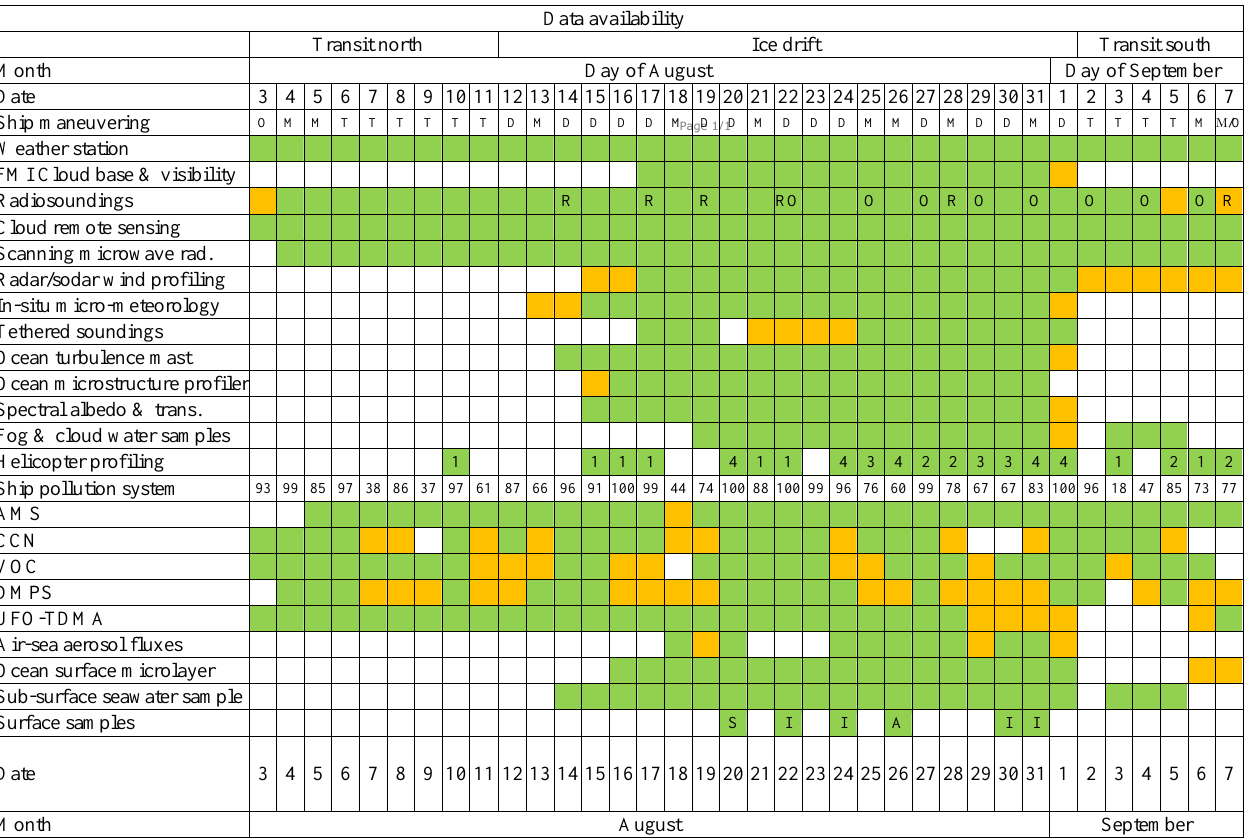
Table 4. Overview of availability of data from different instruments or groups of instruments from ASCOS at different times (3 August corresponds to DoY 215 and 7 September corresponds to DoY 251). Green fields indicate essentially complete data coverage, within the limitations of the deployment, and yellow fields indicate (somewhat arbitrarily) that some limitation in availability was present, either due to problems with the instrumentation, ship pollution, incomplete installations or reduced sampling for some other reason. White fields indicate that data are essentially missing; note that some very small fraction of data may still be present. For some data additional information is provided. “Ships maneuvering” indicates ship’s operation (O: open water sampling, M: MIZ sampling, T: transit, D: drifting with ice, M: temporarily moving the ship while drifting). A fraction of the soundings were augmented by special sensors indicated by “R” for radioactivity and “O” for ozone. For the ship’s pollution system, the numbers indicate the fractional time without any pollution detected, in %. A green field in the helicopter profile column indicates that at least one profile was made on that day; the number of flights is given in the green field. The surface samples are summarize in one row (I: sea ice, S: snow, A: ice